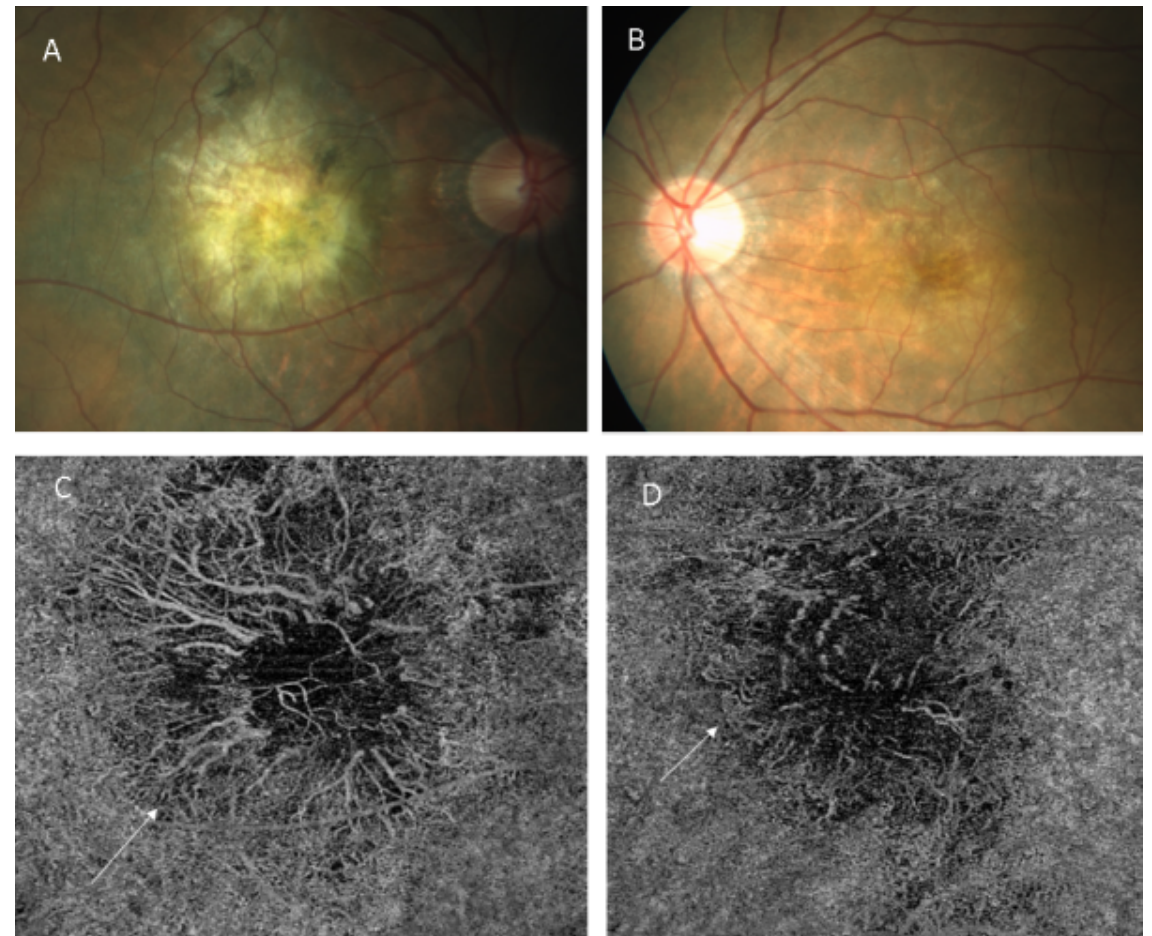
Figure 3: Fundus photos of the right eye (A) and the left eye (B) of the second patient showing similar large mildly elevated subretinal lesions. The right eye shows a more mature yellowish-colored lesion with pigmentation in the superior area, whereas the left eye shows a more active-looking orange lesion. The SSOCTA choriocapillaris slab of the right eye (C) shows a large vascular net fanning out from the central point. The left eye picture (D) shows some motion artefacts in the superior area, but a similar large neovascular network is visible in this eye as well, marked by arrows in both the images.